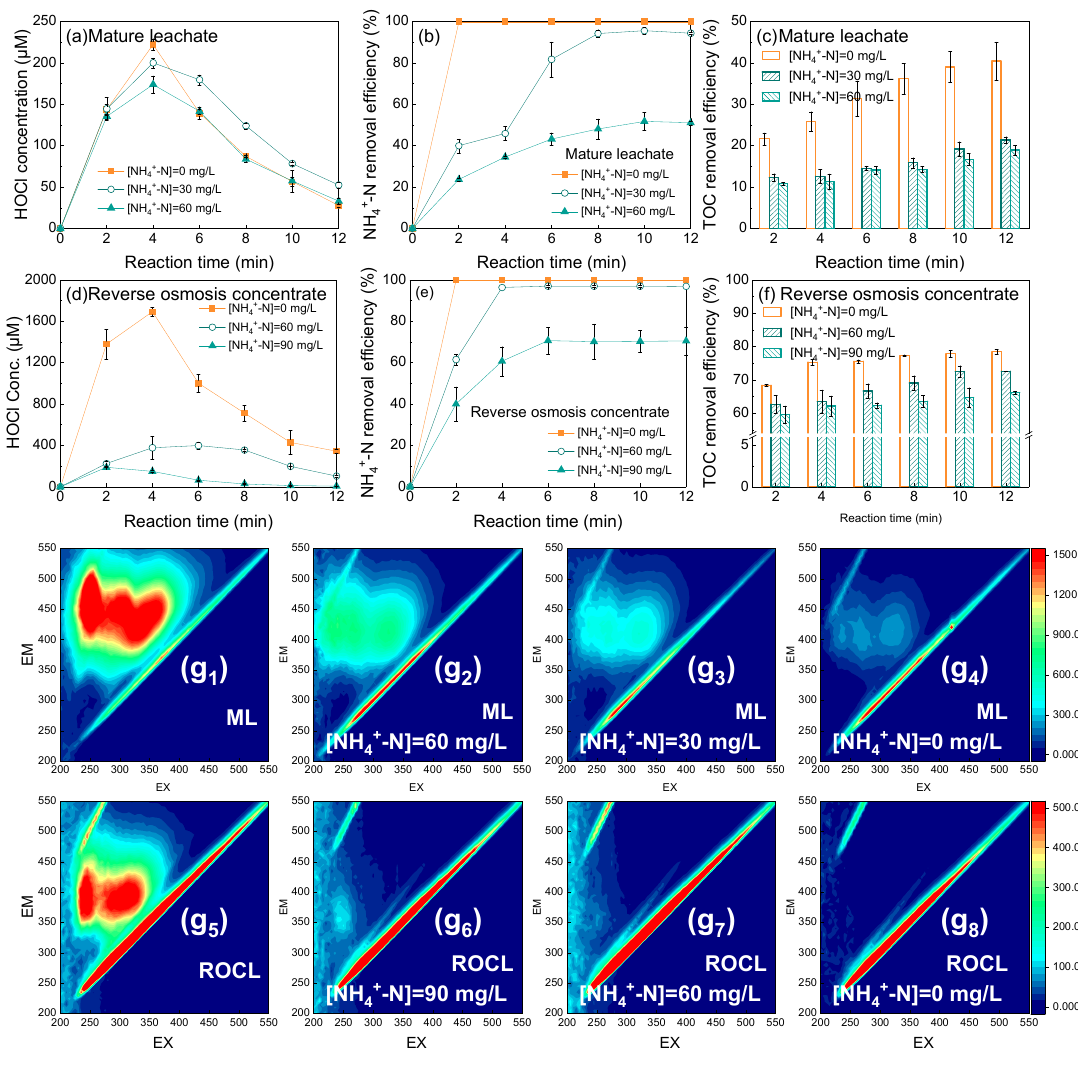
Figure 6. Cumulative concentration of HOCl and removal efficiencies of ammonia nitrogen and TOC in aged landfill leachate ( a – c ) and reverse osmosis concentrate ( d – f ) treated by the MW/PMS system under different conditions of ammonia nitrogen. Comparison of the three-dimensional fluorescence spectra ( g ) before and after reaction. Reaction conditions: MW power = 160 W, [PMS] 0 = 10 mM, [Cl − ] ML = 20.34 mM, [Cl − ] ROCL = 44.26 mM, reaction time=12 min.